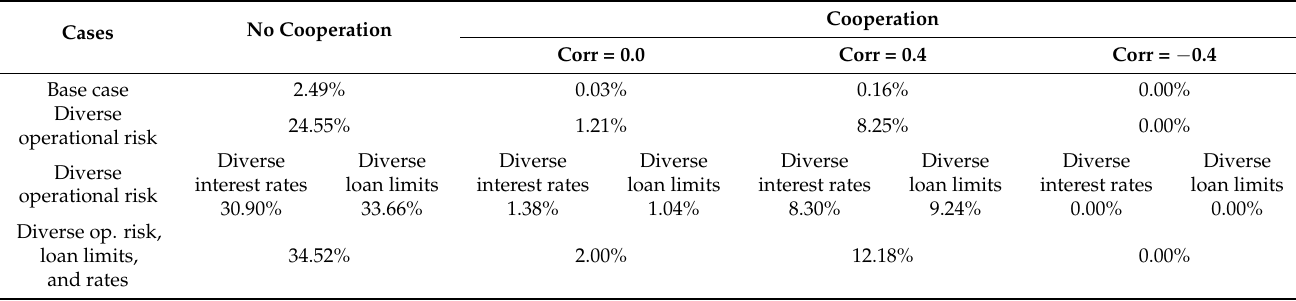
Table 19. Probability of bankruptcy in different